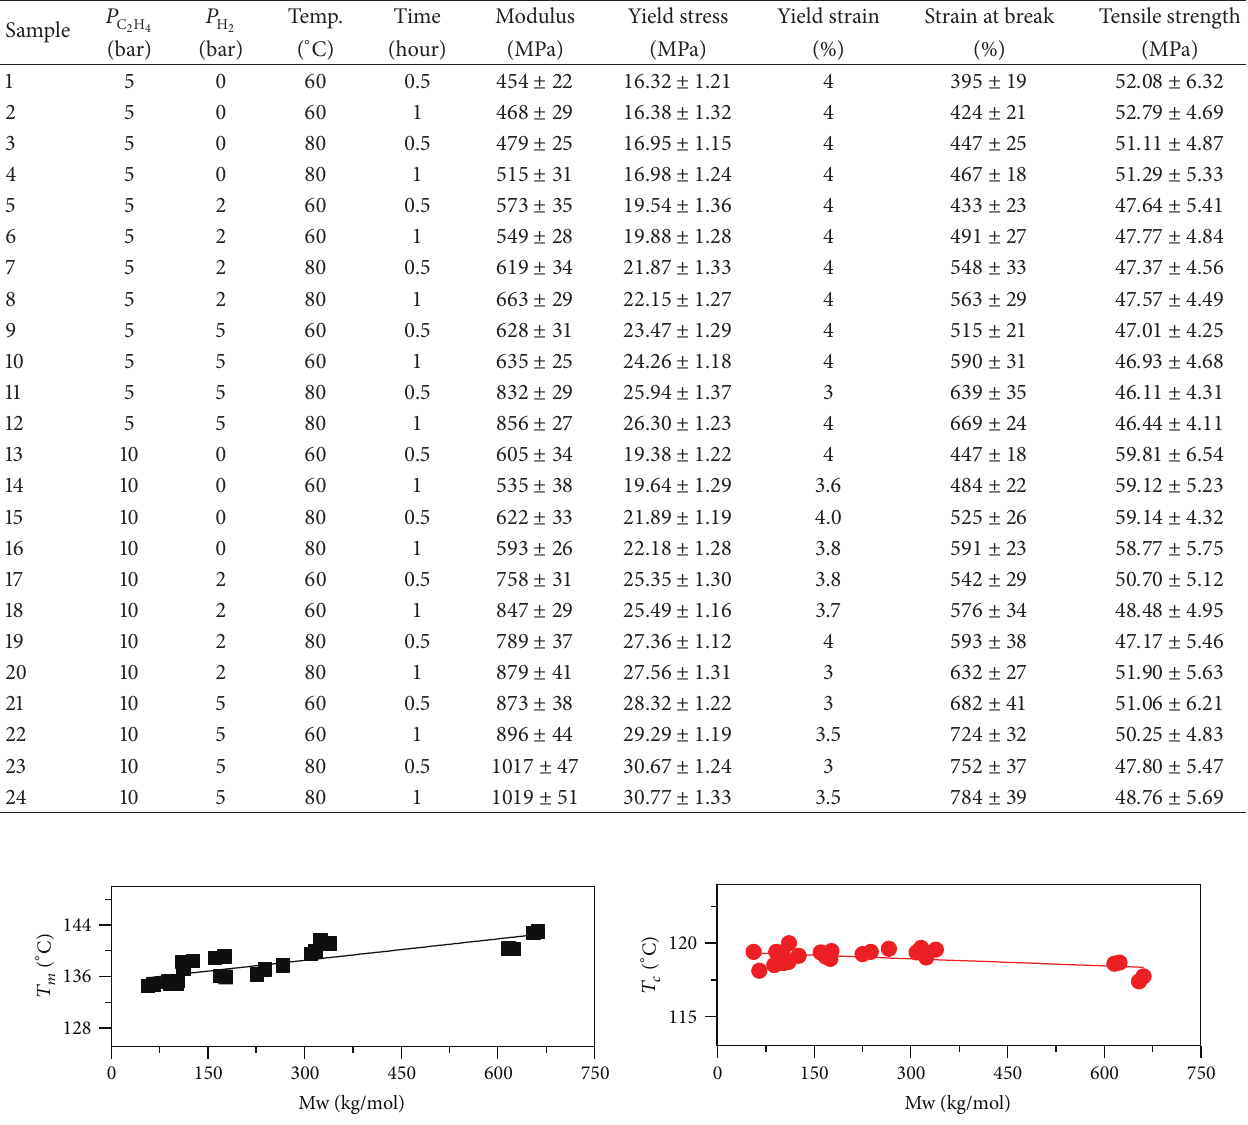
Table 4: Results of mechanical testing for polyethylene samples.